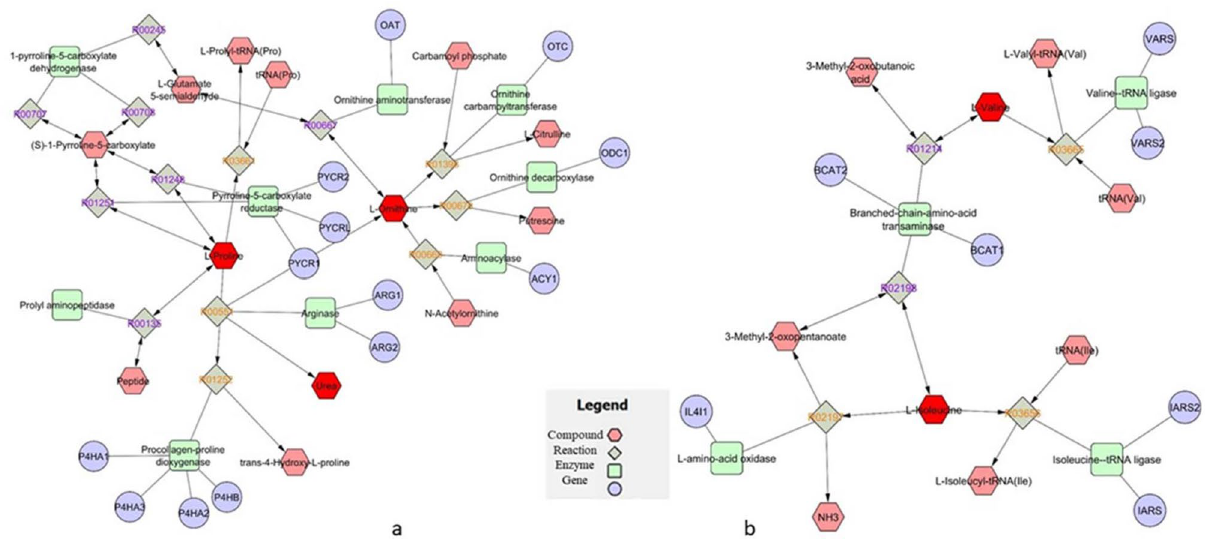
Figure 3. Metabolomics Network interaction analysis on plasma metabolites identified by GC–MS. Selected interaction network of plasma metabolites (see Table 2). The network analysis was performed using the MetScape 3 App for Cytoscape (http:// metsc ape. med. umich. edu). Metscape is part of the National Institutes of Health-supported National Center for Integrative Biomedical Informatics (NCIBI) suite of tools, freely available at http:// metsc ape. ncibi. org . It can be downloaded from http:// cytos cape. org or installed via Cytoscape plugin manager. Panel ( a ) urea metabolism linked to proline and ornithine metabolism; panel ( b ) branched chain amino acids metabolism. Node colors and shapes indicate different